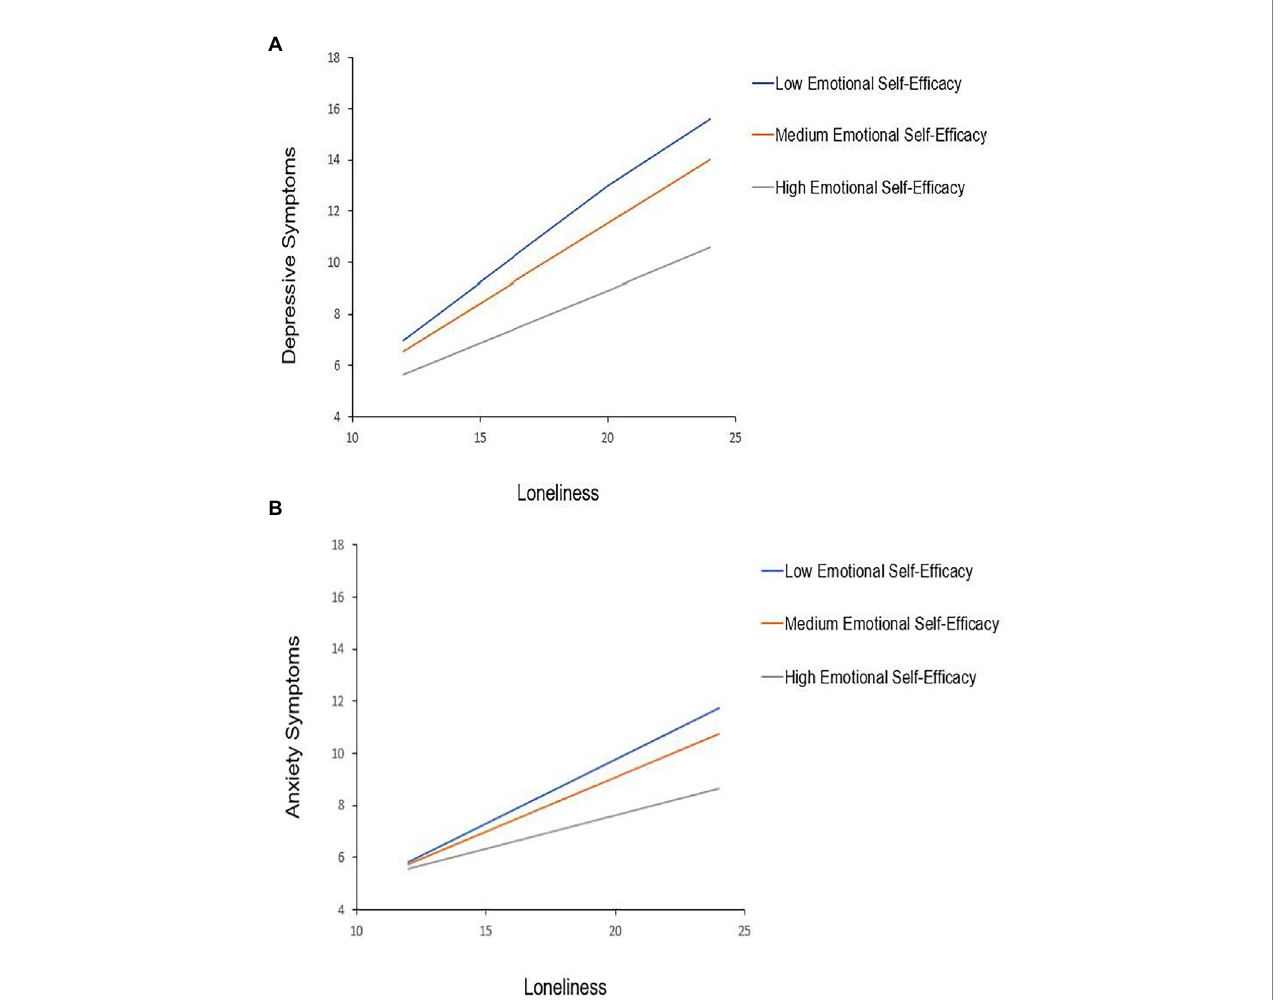
FIGURE 2 Emotional self-efficacy moderates the association between loneliness and mental health symptoms. The association between loneliness (possible score range: 8–32) and mental health symptoms [ (A) depression possible score range: 0–27; (B) anxiety possible score range: 0–12] is moderated by emotional self-efficacy in separate hierarchical regression models with all specified covariates included. The simple slopes for 16th (3.38), 50th (4.13), and 84th (5.75) percentiles of emotional self-efficacy scores are displayed (all p < 0.001). Models included the following covariates: binary gender, sex, race, ethnicity, whether in a relationship, better or worse off financially due to the pandemic (reference group: no impact of pandemic), less than or more than 4-year college degree attainment (reference group: 4-year college degree), social desirability, and dispositional optimism. Analyses only included participants with binary gender identity because a sample size for non-binary gender meant the study was underpowered to test for any statistically significant differences for this groups. N =